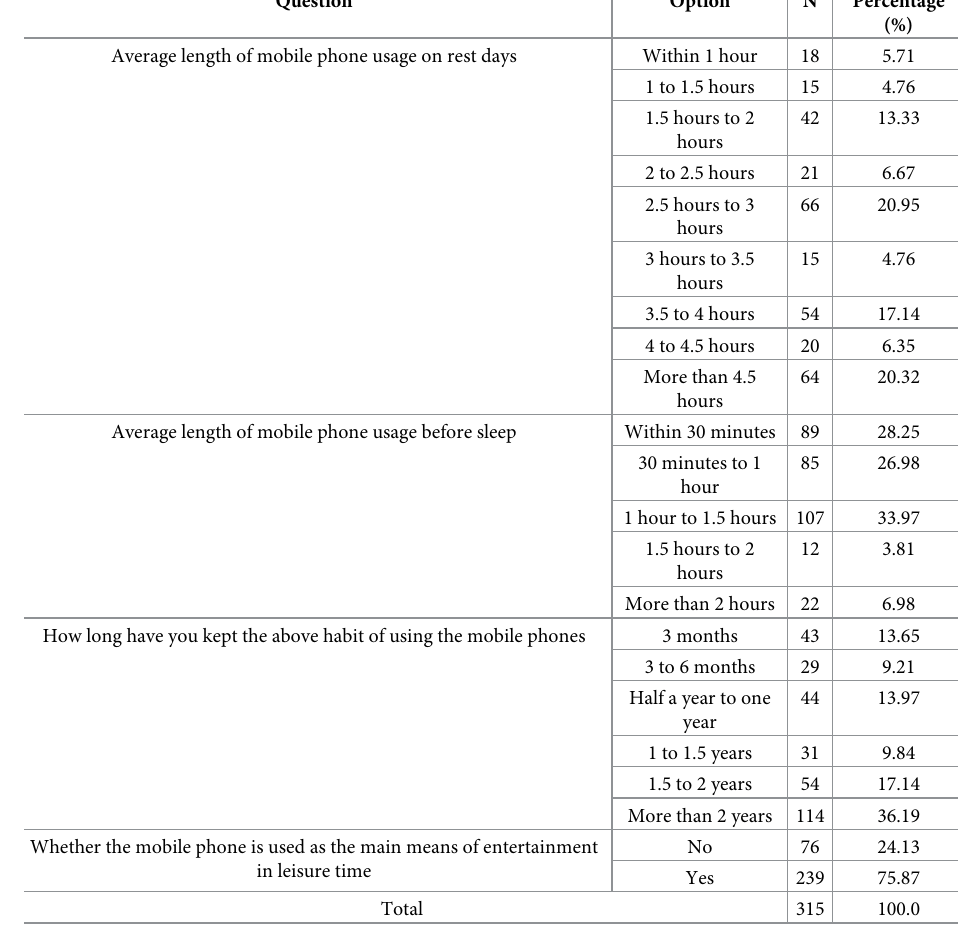
Table 6. Mobile phone usage information. Question Option Average length of mobile phone usage on rest days